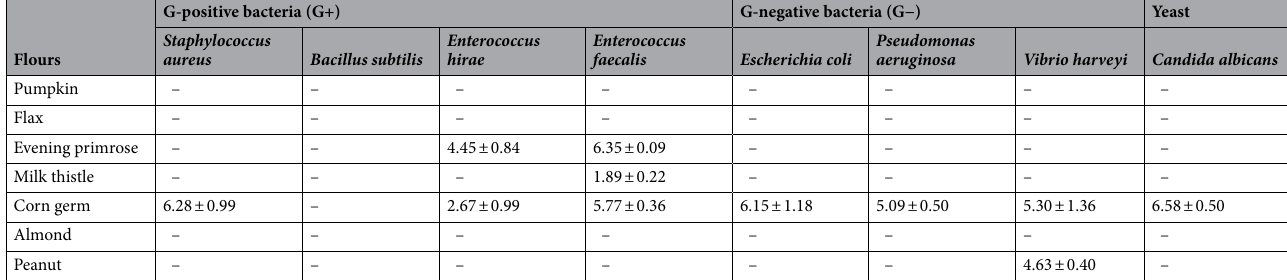
Table 1. Zones of inhibition (mm) in the growth of microorganism of selected cold-pressed seed flours. – Not identified (trace or % < 0.1).